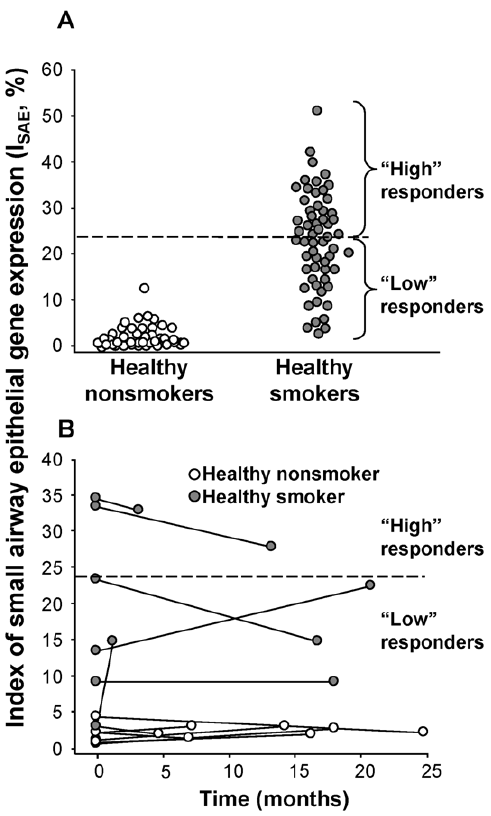
Figure 2. Index for small airway epithelial gene expression (I SAE ). A. I SAE values for nonsmokers (white circles, n=47) and healthy smokers (gray circles, n=58). The dashed line demarcates the median I SAE value for the healthy smokers. Individuals with lower I SAE demonstrate abnormal expression of relatively few smoking-responsive genes, and individuals with the highest I SAE values abnormally express the greatest numbers of smoking-responsive genes. Individuals below the median are termed ‘‘low’’ responders and those above the median ‘‘high’’ responders to the stress of smoking. B. Assessment of stability of the I SAE over time. Healthy nonsmokers (n=7, white circles) and healthy smokers (n=6, gray circles) had assessments of I SAE at time 0 and again at times up to nearly 25 months. All nonsmokers had I SAE values that remained , 5%. Among the healthy smokers, 4 low responders remained low responders and 2 high responders remained high responders over time.